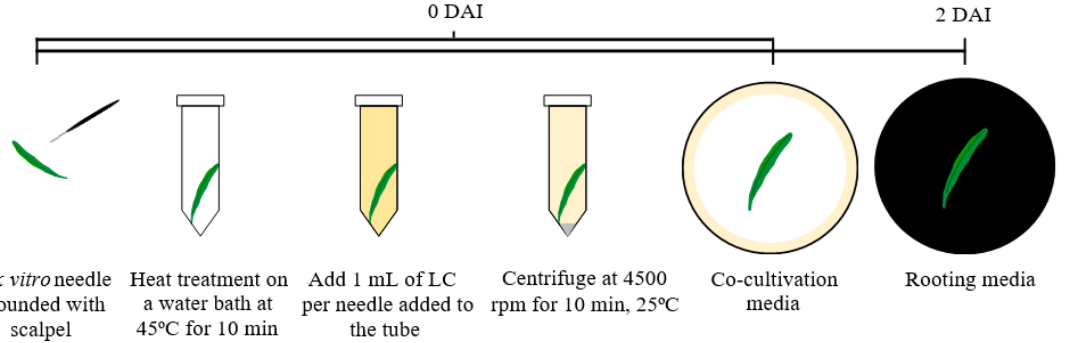
Figure 3. Schematic representation of the inoculation of ex vitro needles by the liquid co-culture method. DAI: days after infection; LC: liquid culture of R. rhizogenes .